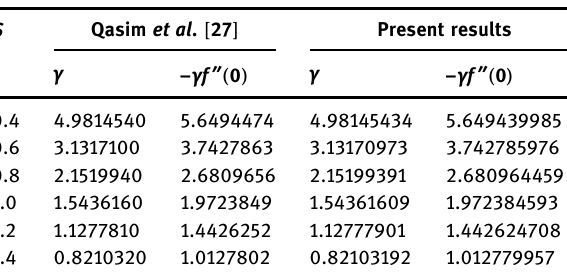
Table 1: Thickness fi lm γ and the values of the drag force ( ) f − ″ 0 for assorted value of S with → β